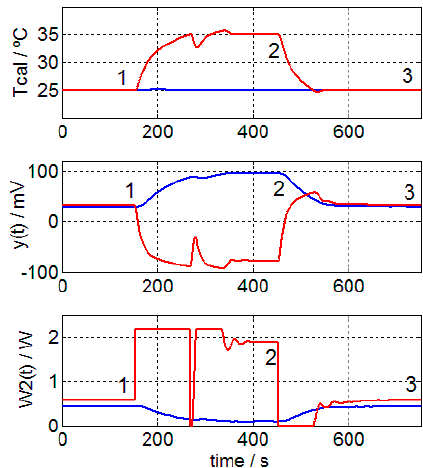
Figure 12. Measurements to determine the thermal resistance of each sensor, including thermostat temperature ( Tcal ), calorimetric signal ( y ( t )) and power dissipated in the thermostat ( W 2 ( t )). These are curves of the minisensor S1 (blue) and minisensor S2 (red). Steady states are marked 1, 2 and 3. The measurement of power on the surface of the human body at several thermostat temperatures ( Tcal ) was determined with the described method. The variation of A 0 with a change in temperature Tcal provides the slope of the fitting line, which is directly related to the thermal resistance between two supposed points of different temperatures: the thermostat of the minisensor and the interior of the human body. At the steady state, the heat flux between both points is A 0 . Hence, the inverse of the slope of the line is the total thermal resistance ( R T ) between both points. The resistance corresponding to the area of the human body will be R body = R T ‒ R sensor .